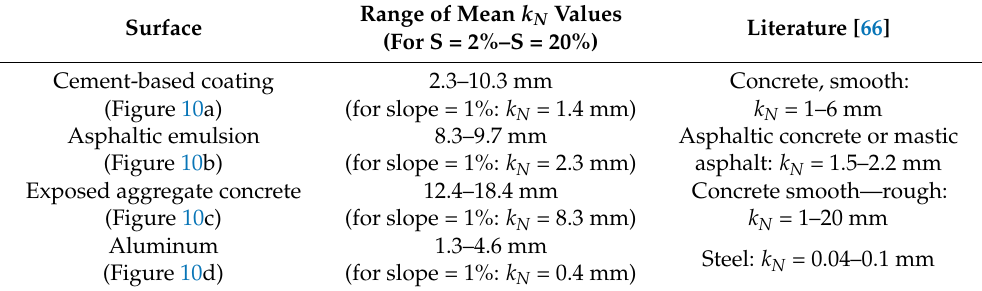
Table 2. Derived, mean k N values from experiments of this study and literature references.